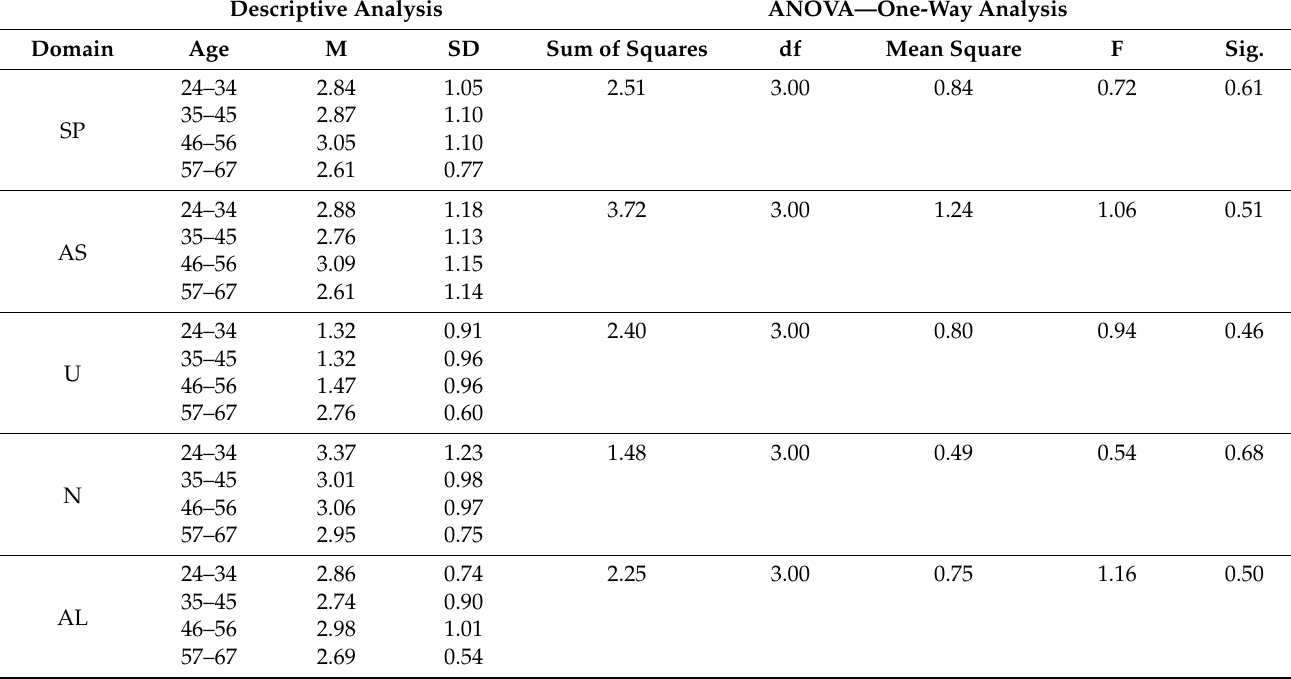
Table 4 delineates the descriptive and one-way ANOVA analysis comparing the five TLS © domains by age. Table 4. Descriptive and one-way analysis of toxic leadership domains and